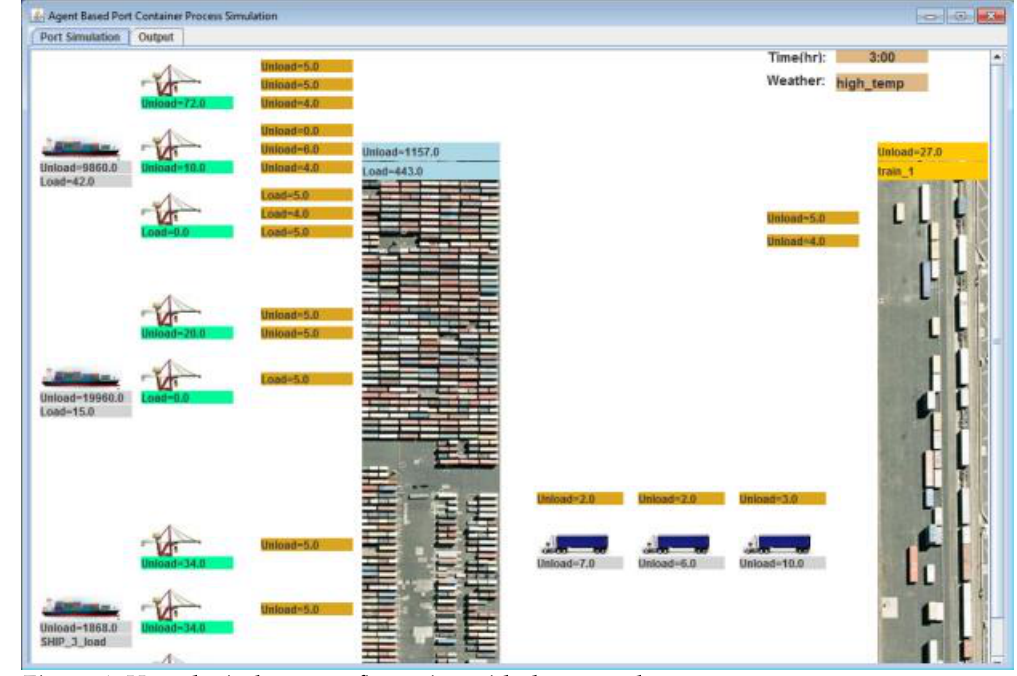
Figure 4. Hypothetical port configuration with three vessels Table 9. Impact on Hourly KPIs